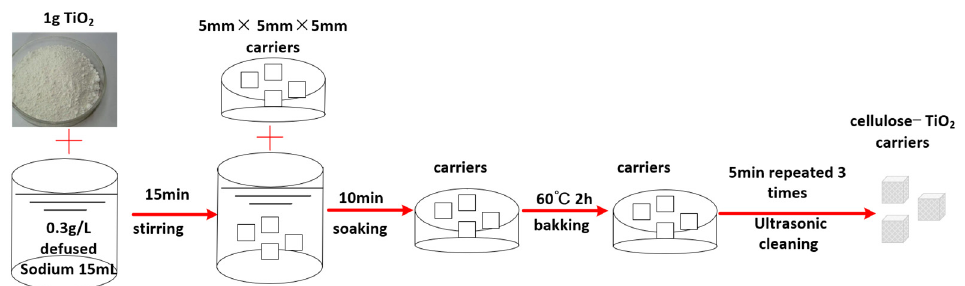
Figure 2. Preparation of cellulose-TiO 2 carrier.